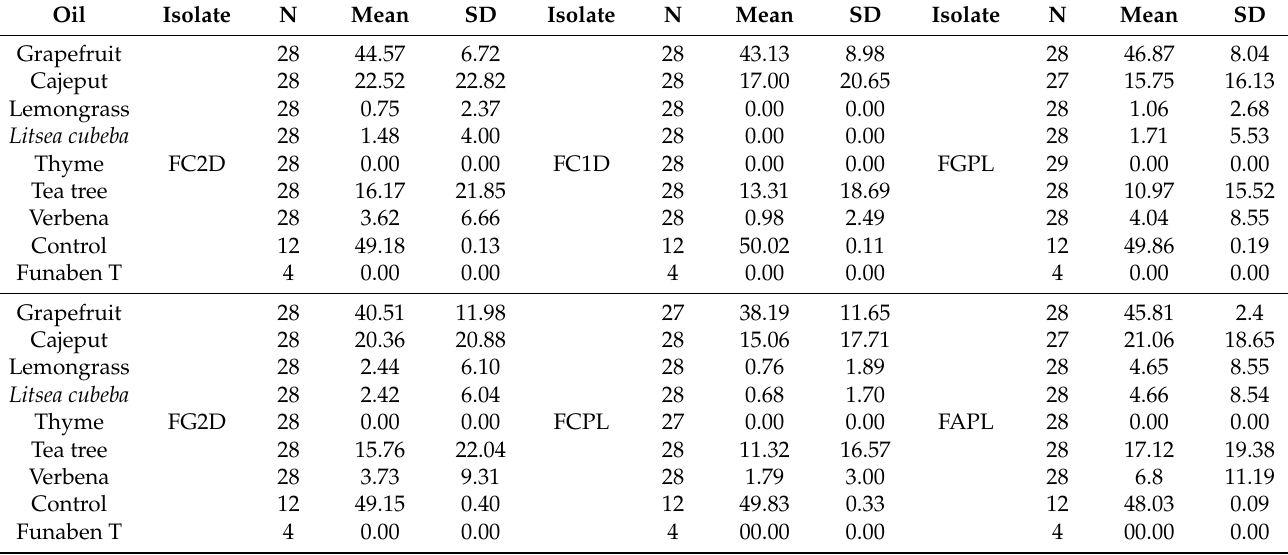
Table 2. Descriptive statistics for the growth rate index of all tested Fusarium isolates; for all concentrations of essential oils together Fusarium : FC2D— F. culmorum , FG2D— F. graminearum , FG1D— F. graminearum , FC1D— F. culmorum , FCPL— F. culmorum , FP0D— F. poae , FGPL— F. graminearum , FAPL— F. avenaceum , FOPL— F. oxysporum . control–isolates without EsO or Funaben T. Notation: N—test volume, SD—standard